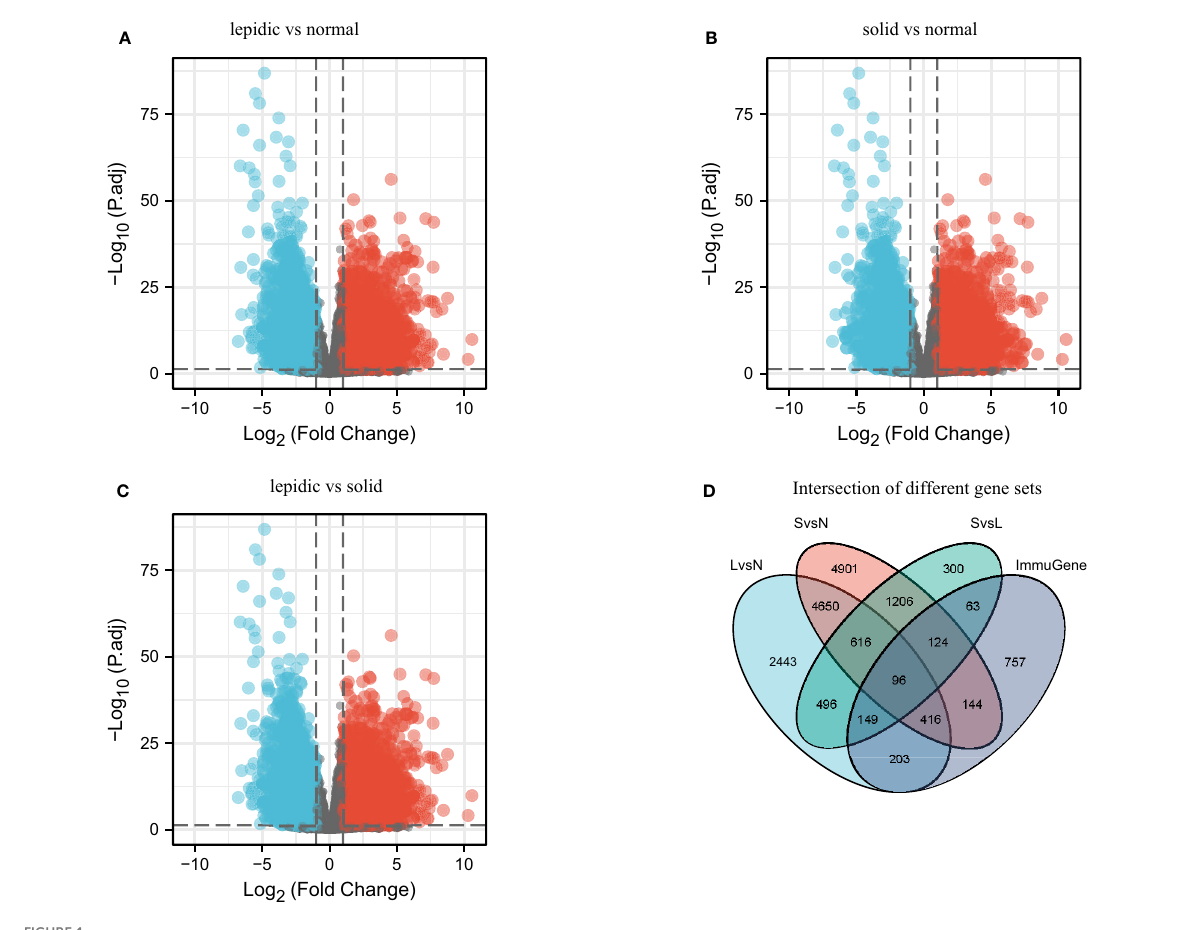
FIGURE 1 Differential analysis between normal, lepidic, and solid histologic subtypes. (A) Differential expression genes between lepidic and normal samples (LvsN). (B) Differential expression genes between solid and normal samples (SvsN). (C) Differential expression genes between lepidic and solid samples (LvsS). (D) Intersection of differentially expressed genes and immune genes